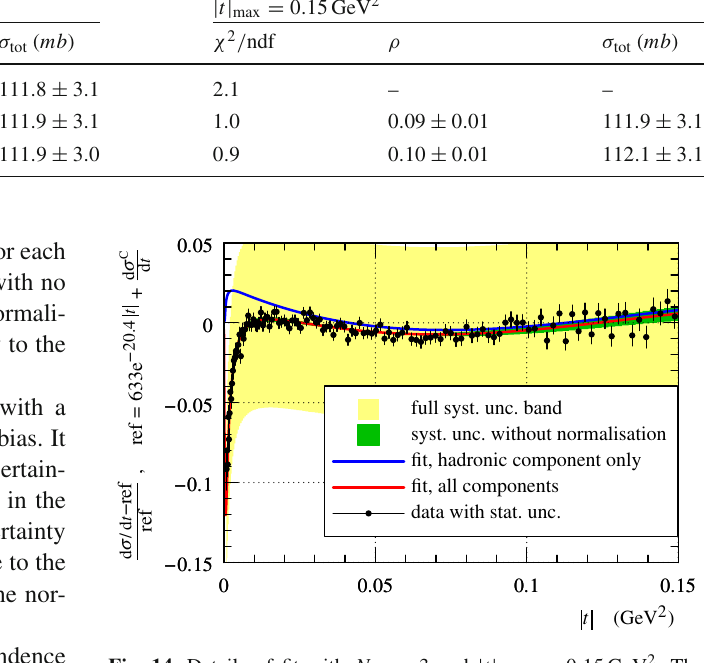
Fig. 14 Details of fit with N b = 3 and | t | max = 0 . 15GeV 2 . The fit parameters read: a = ( 648 ± 34 ) mb / GeV 2 , b 1 = ( 10 . 64 ± 0 . 08 ) GeV − 2 , b 2 = ( 4 . 1 ± 1 . 1 ) GeV − 4 , b 3 = ( 10 . 3 ± 4 . 9 ) GeV − 6 and ρ = 0 . 10 ± 0 .